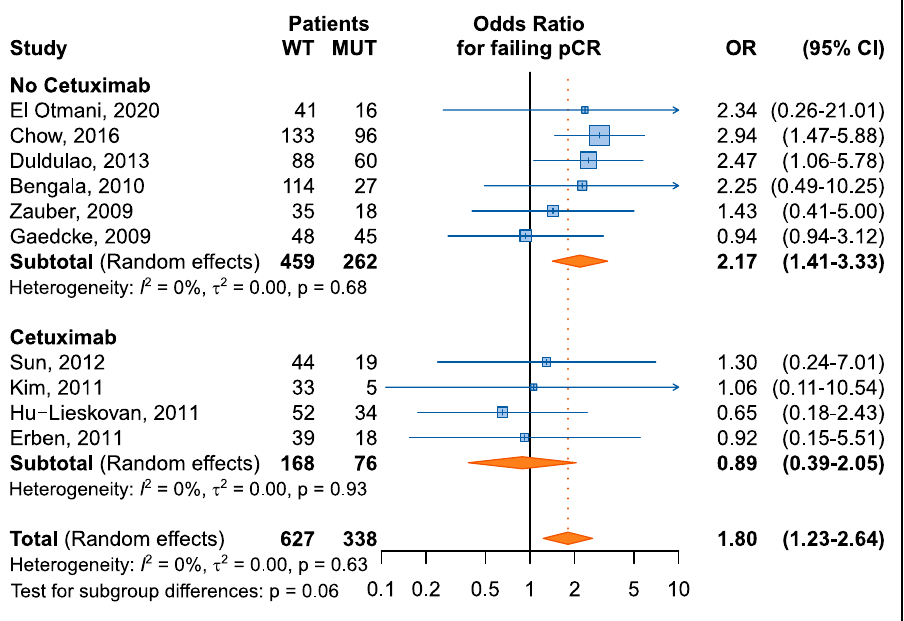
Figure 3. Forrest plot for the risk of not achieving a pathological complete response (pCR) in patients with a KRAS mutation according by cetuximab treatment [29,31–39].